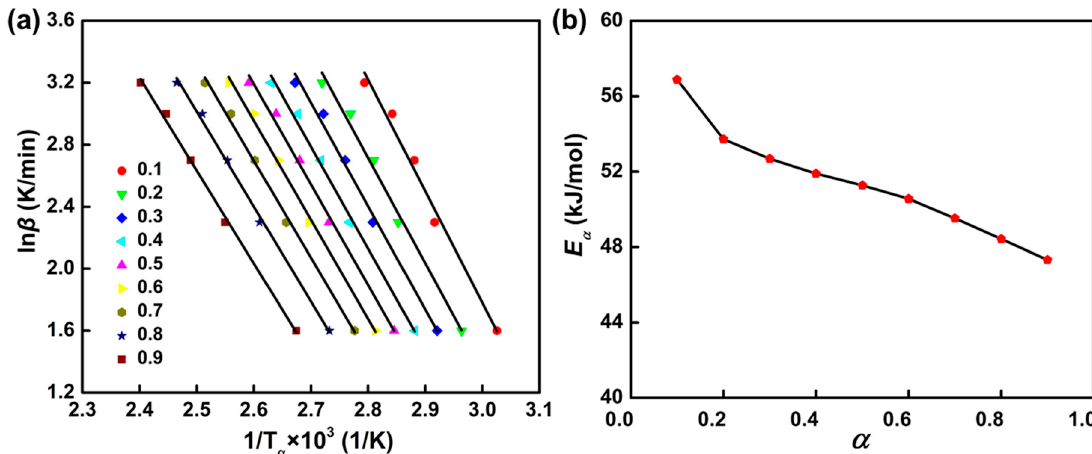
Figure 7. ( a ) Ozawa–Flynn–Wall method to determine apparent activation energy at different conversion rates. ( b ) Dependence of apparent activation energy on the conversion of the phenolic amine/epoxy resin system.